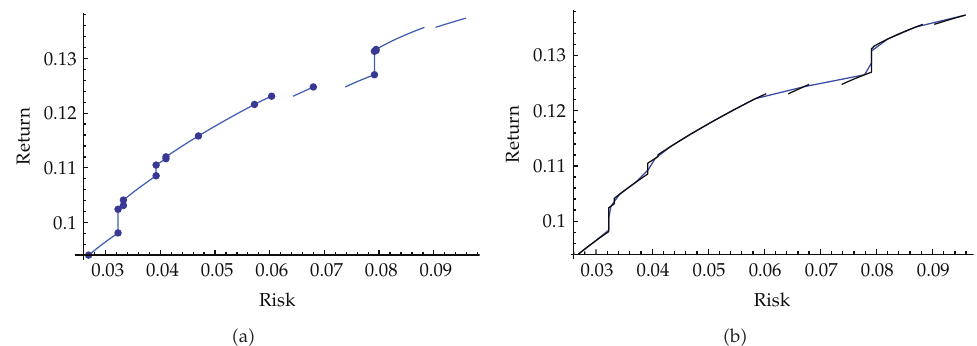
Figure 7: (cid:6) a (cid:7) The true e ffi cient frontier. (cid:6) b (cid:7) The true frontier and a standard